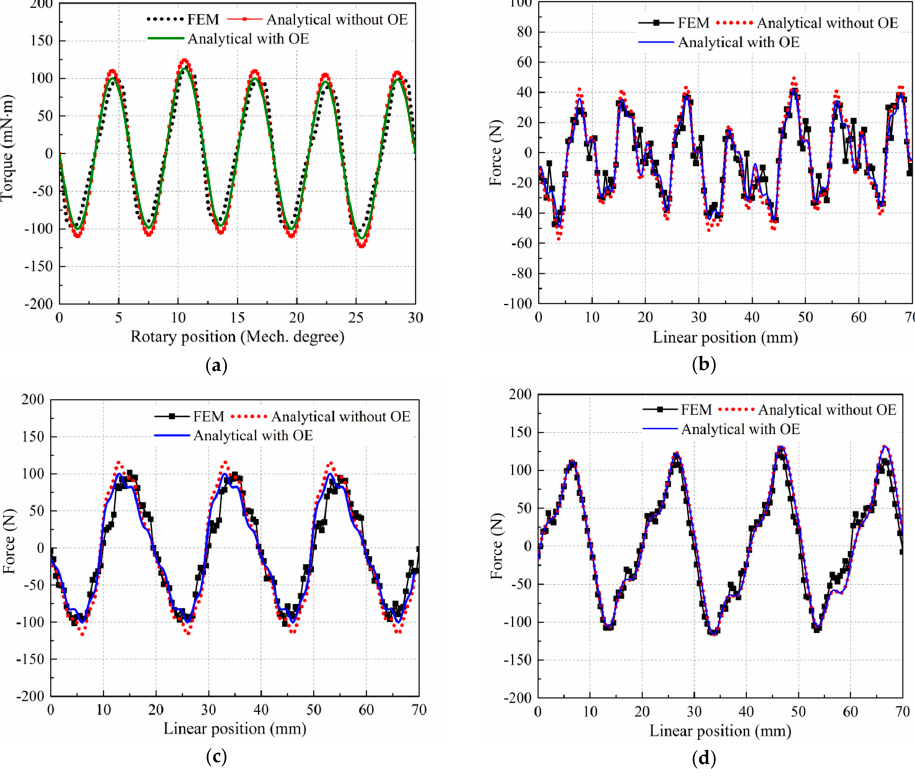
Figure 15. ( a ) Cogging torque of the rotary motion unit; ( b ) detent force of the linear motion unit; ( c ) cogging force of the linear motion unit; and ( d ) end force of the linear motion unit.